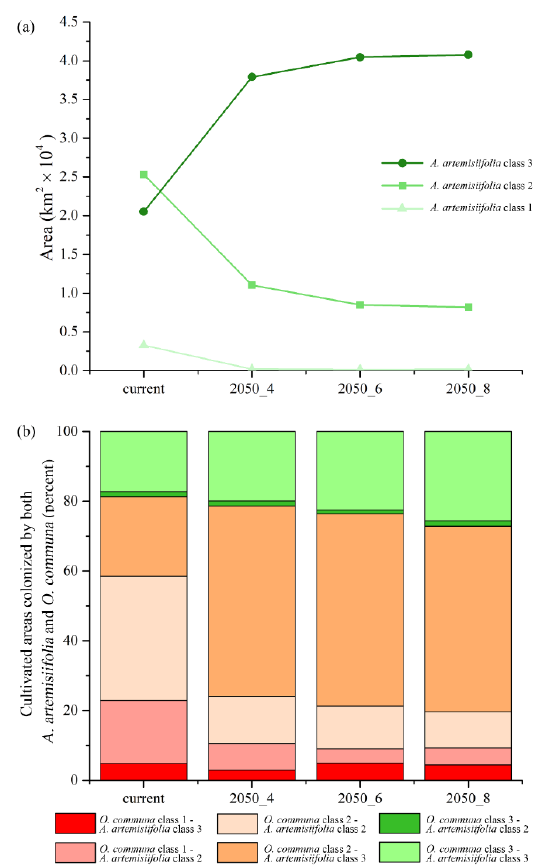
Figure 5. Trends for Ambrosia artemisiifolia and cumulative areas shared by target species in agricultural areas. Areas predicted as suitable (class 1 = low; class 2 = medium; class 3 = high) for Ambrosia artemisiifolia falling within target agricultural patches in the different time frames considered ( a ); areas (percent, cumulative) potentially shared by both Ambrosia artemisiifolia and Ophraella communa for the different suitability classes (class 1 = low; class 2 = medium; class 3 = high) and time frames considered, falling within target agricultural patches ( b ).